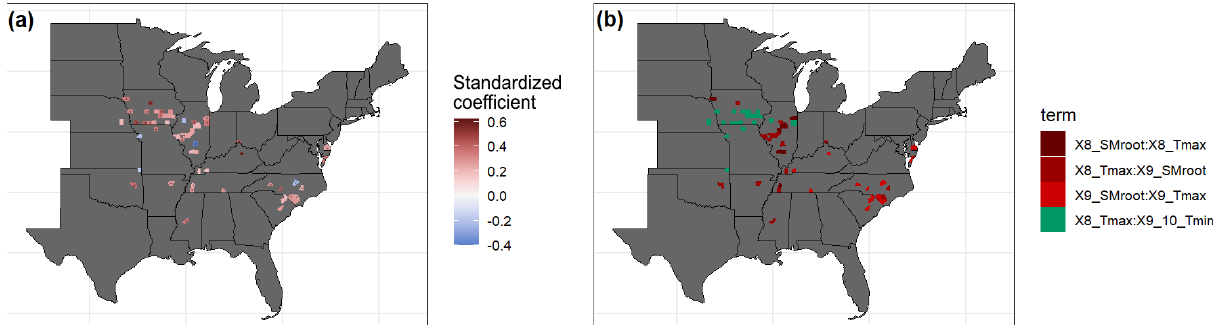
Figure A3. (a) Standardized coefficients for interaction terms per county selected based on the full dataset. (b) Type of interactions selected per county based on the full